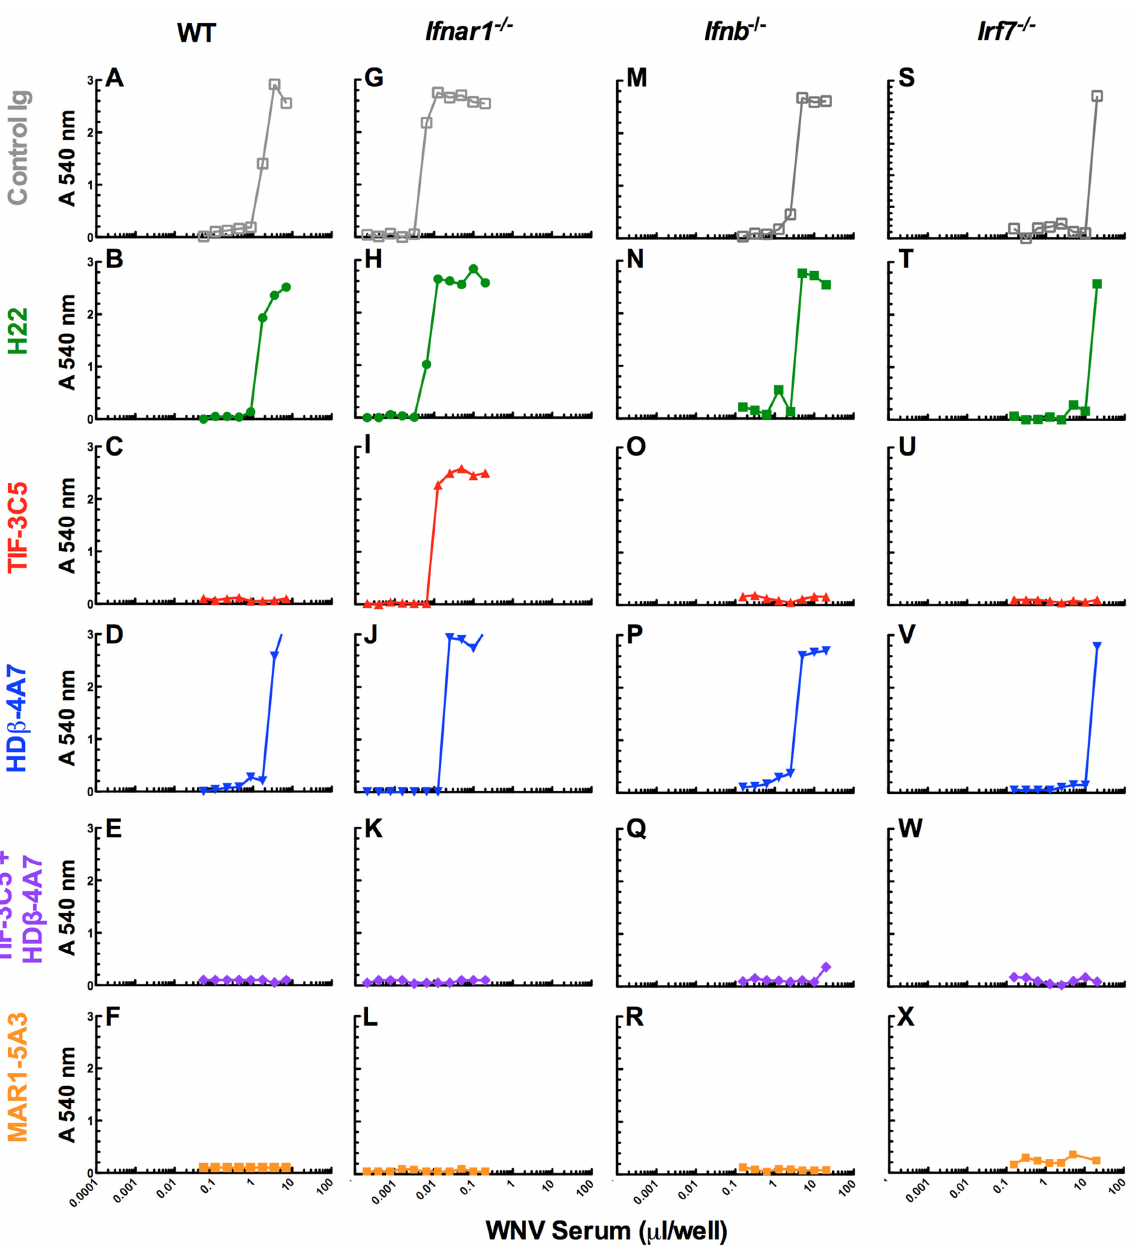
Fig 7. Detection of IFN- β and IFN- α in serum following WNV infection. Serum was collected from wild-type ( A-F ), Ifnar1 -/- ( G-L ), Ifnb -/- ( M-R ) or Irf7 -/- ( S-X ) mice infected with 10 2 PFU of WNV at day 3 (wild-type and Ifnar1 -/- ) or day 4 ( Ifnb -/- and Irf7 -/- ). Volumes of serum containing approximately 5 – 10 units of IFN activity (as determined in Fig 4) were incubated with 10 μ g of mAb for 1 h and then titrations were added to L929 cells overnight. IFN-treated cells were infected with VSV and cellular viability assessed after 48 h using crystal violet staining and optical density measurements. Each panel is representative of six independent